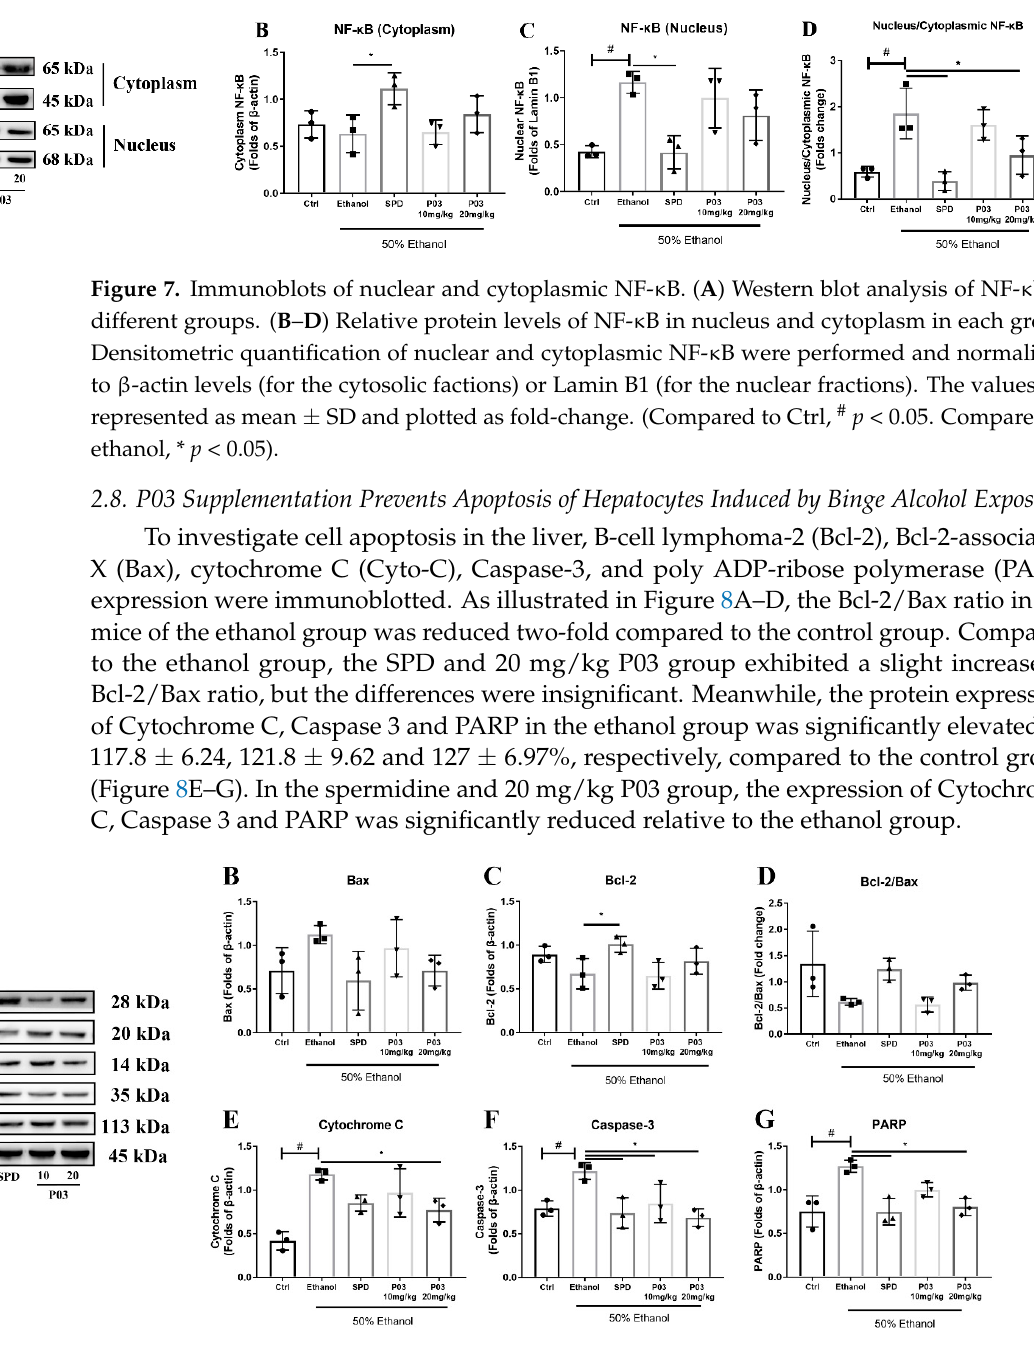
Figure 6. Anti-inflammatory effects of P03 in mice with binge alcohol exposure. ( A – E ) Representa- tive images of histological liver sections after H&E staining. Sections were visualized using Bioquant Osteo (20×). Yellow arrows represent neutrophil infiltration surrounding the central vein (CV); blue arrows represent microvesicular steatosis. Scale bar = 50 μ M. ( F – I ) Serum levels of inflammatory cytokines and LPS in different groups. Comparisons were made with one-way ANOVA. Values are represented as mean ± SD. (Compared to Ctrl, # p < 0.05. Compared to ethanol, * p < 0.05) ( n = 5).